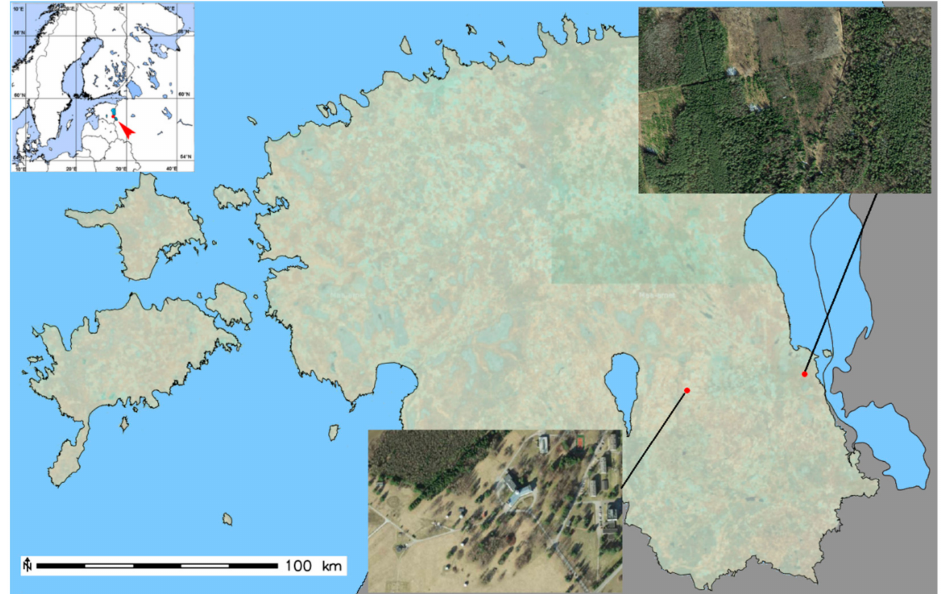
Figure 2. Map of sampling location in Estonia (upper left corner), map of location of both sites: T õ ravere park adjacent to Tartu Observatory (left) and Järvselja Experimental Forest district (right) with aerial photos of